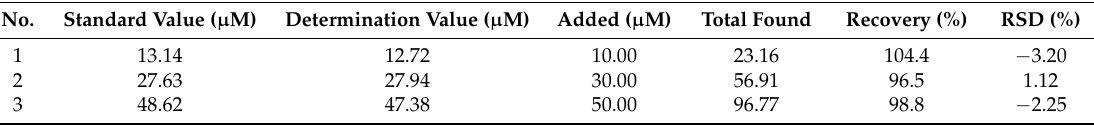
Table 2. The results of determination of dopamine hydrochloride injections ( n =